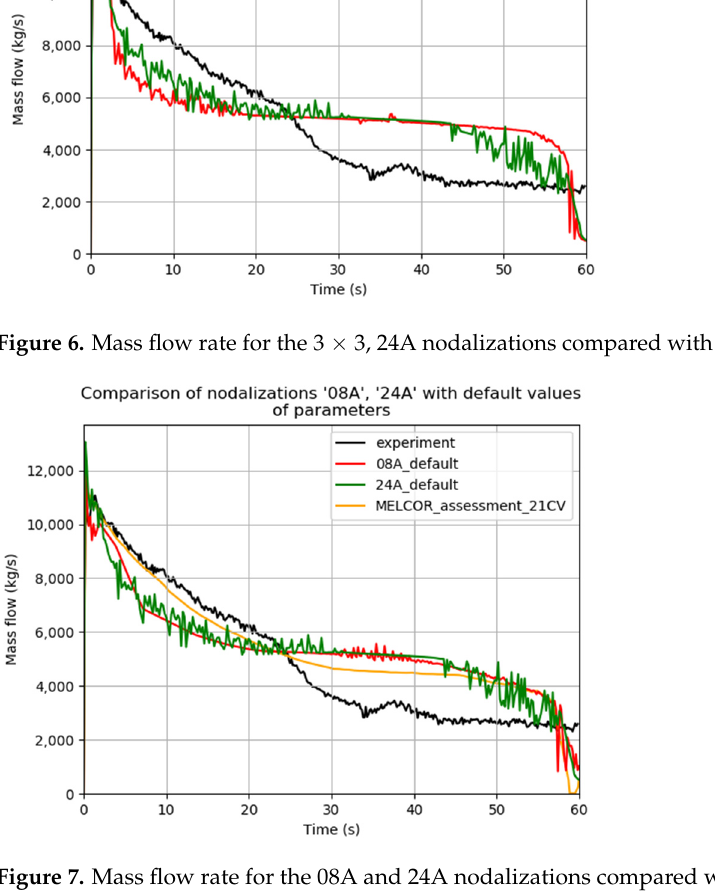
Figure 7. Mass flow rate for the 08A and 24A nodalizations compared with the experimental data and MELCOR results taken from reference [3].